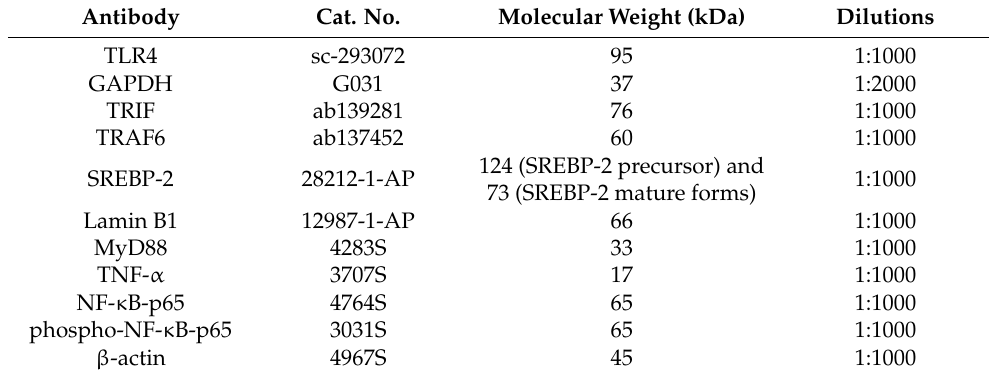
Table 1. The information for the primary antibodies used in the present work. Antibody Cat. No. Molecular Weight (kDa)